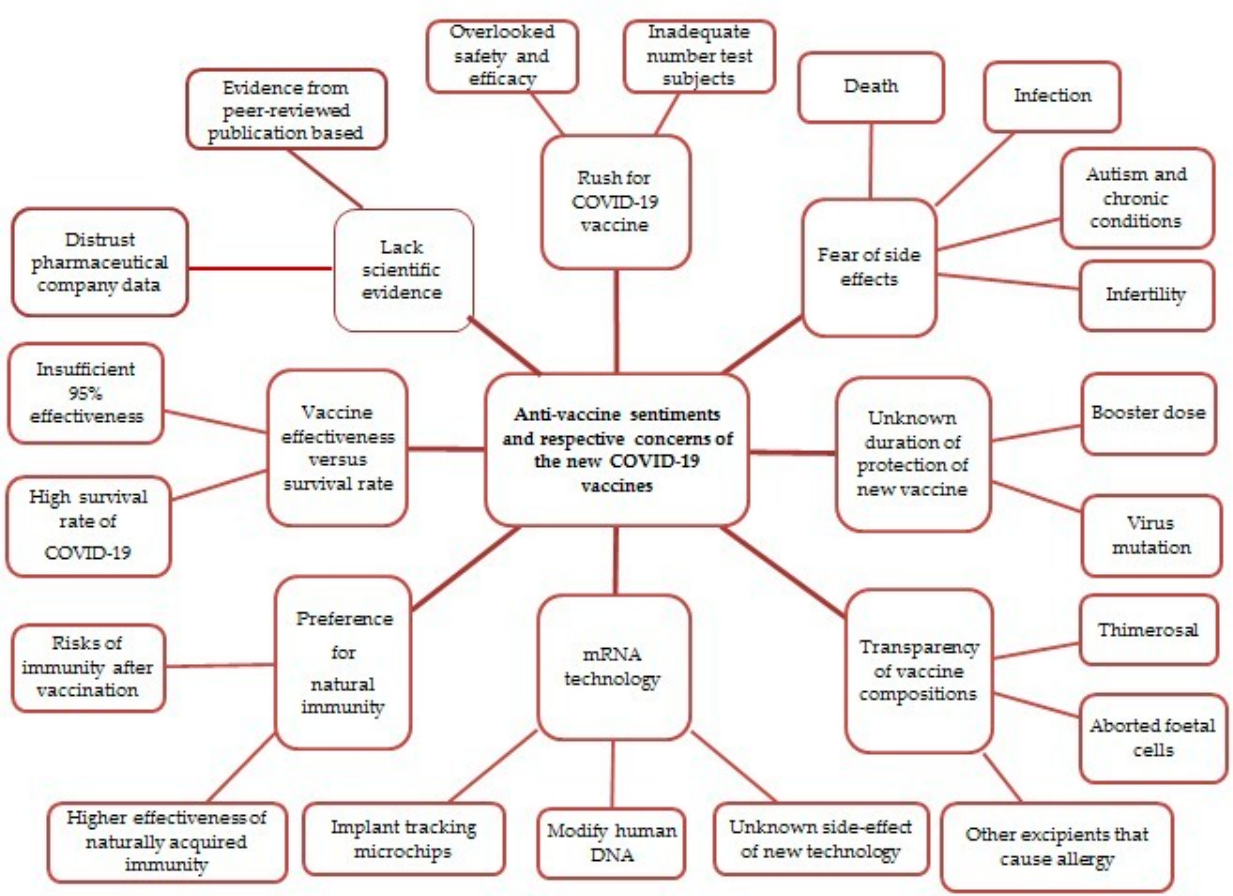
Figure 1. Anti-vaccine sentiments and respective concerns of the new COVID-19 vaccines.